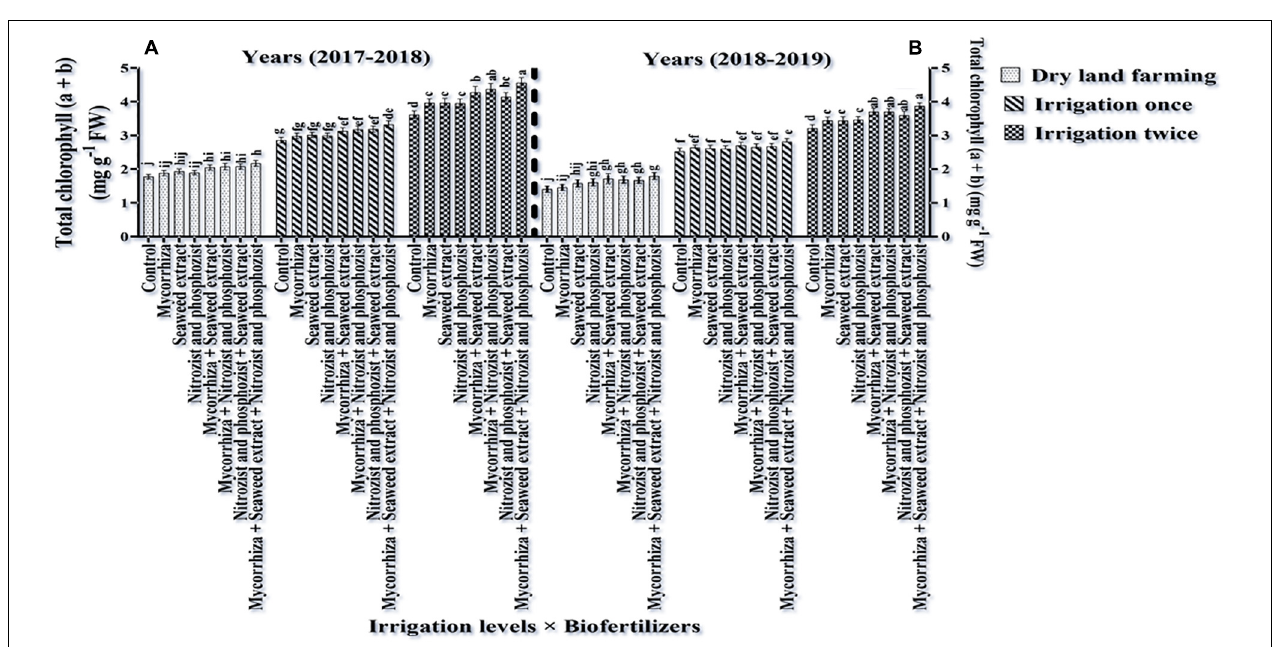
FIGURE 12 | Mean comparisons of the dual interaction effect of irrigation × biofertilizers on total chlorophyll content of wheat plant in two seasons of experiment (A,B) (2017–2018 and 2018–2019). Means in each column followed by similar letter(s) are not significantly different at 1% probability level by the LSD test.